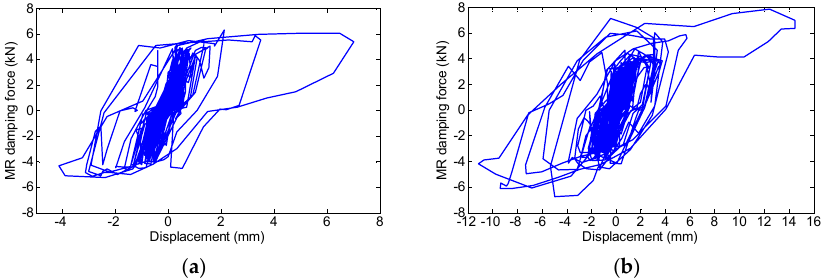
Figure 14. Damper hysteretic curves for Taft wave with ( a ) fortification intensity, and ( b ) rare intensity of earthquake.